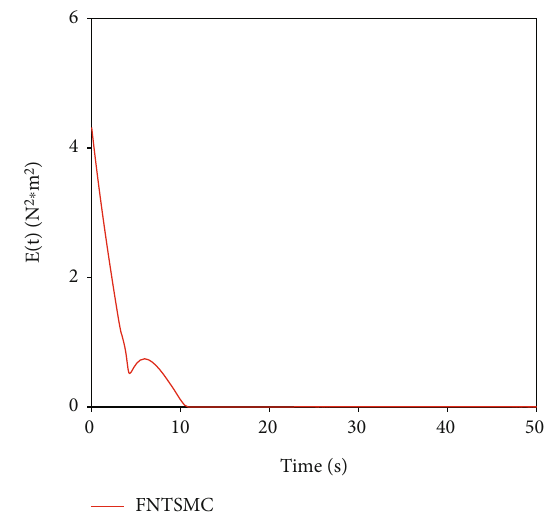
Figure 5: Time response of energy